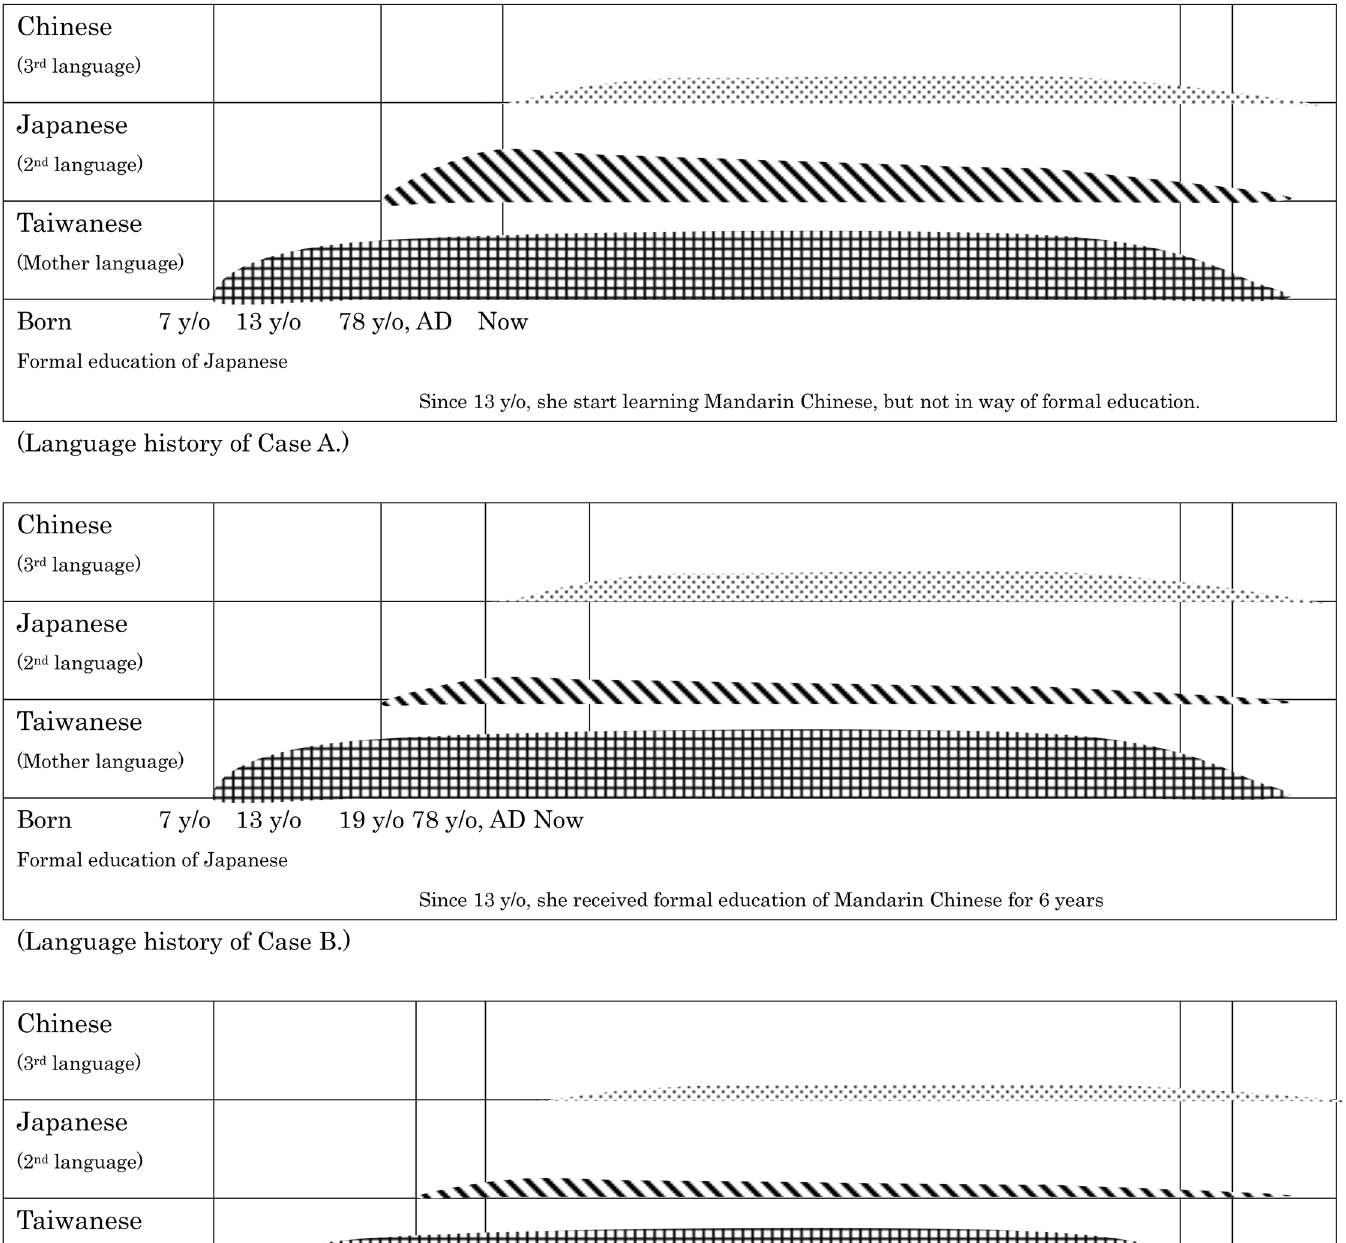
PLOS ONE | DOI:10.1371/journal.pone.0140714 November 10,